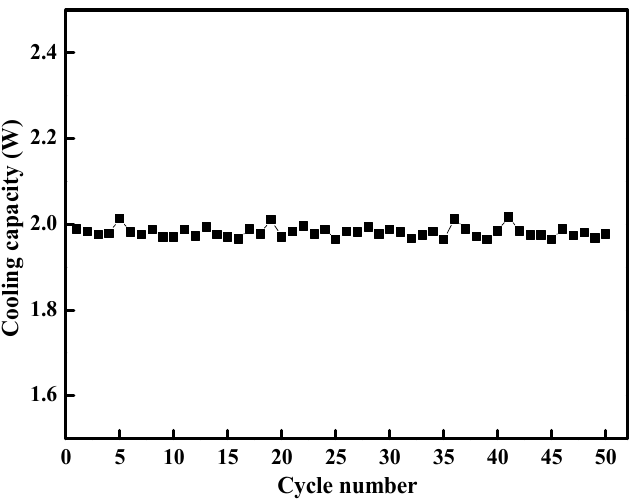
Figure 12. Cyclic cooling capacity of an MIL-101/20%FLG-water working pair. As seen in Figure 12, the cooling capacity of an MIL-101/20%FLG-water working pair is maintained at 1.96 – 2.01 W after 50 continuous adsorption/desorption cycles.